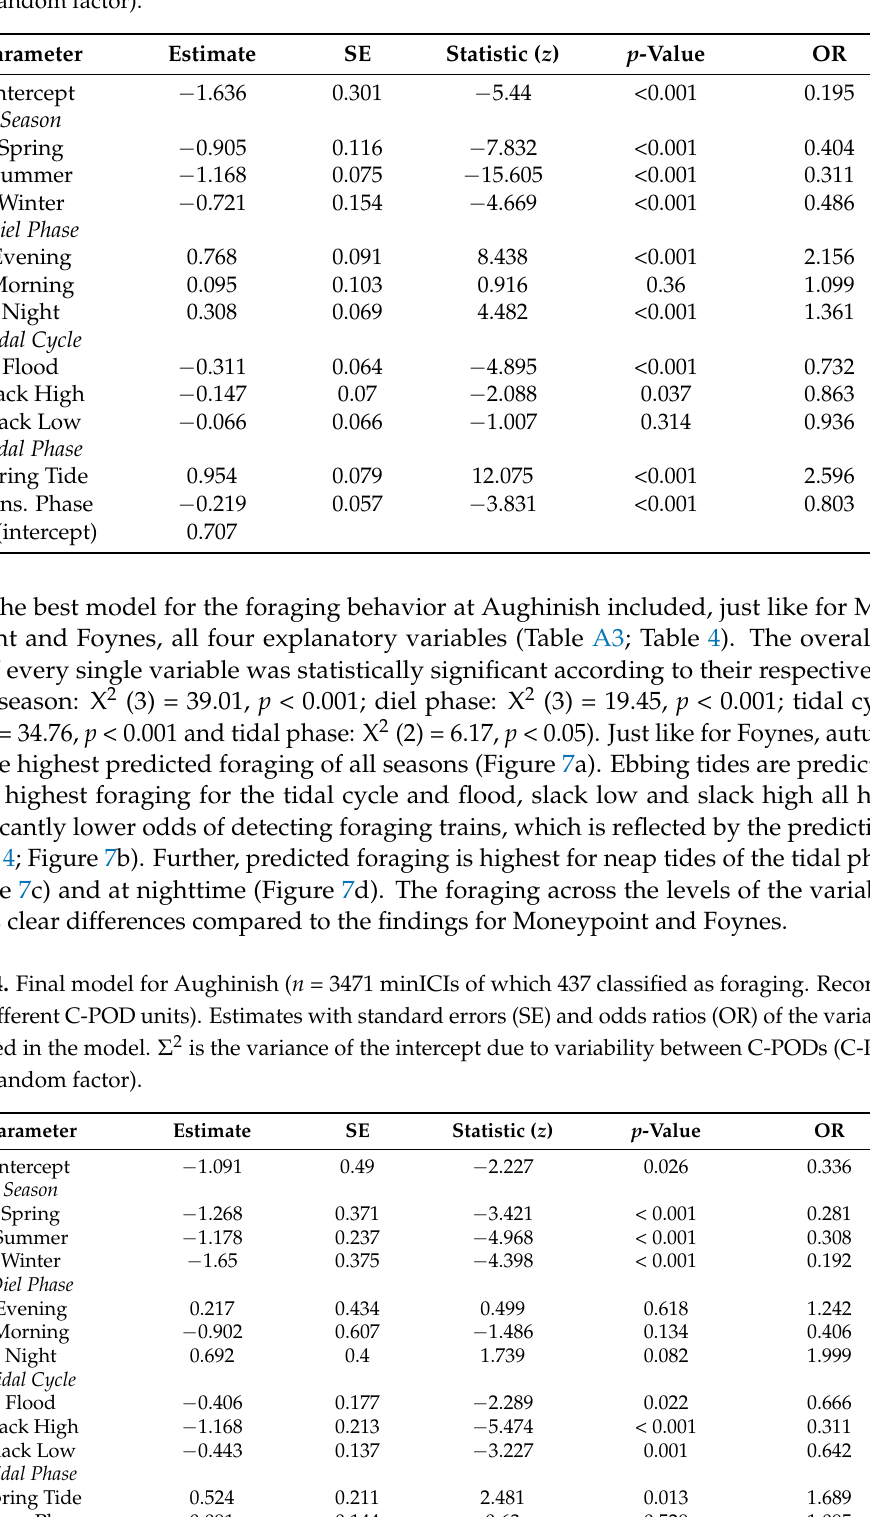
Table 3. Final model for Foynes ( n = 16,445 minICIs of which 2538 classified as foraging. Recorded by 9 different C-POD units). Estimates with standard errors (SE) and odds ratios (OR) of the variables included in the model. Σ 2 is the variance of the intercept due to variability between C-PODs (C-POD ID as random factor).